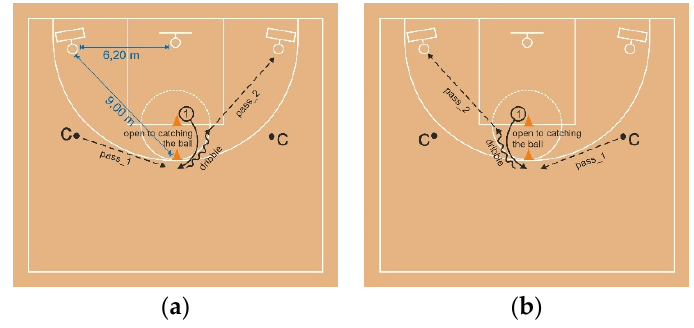
Figure 1. ( a ) push pass on the right side; ( b ) push pass on the left side.